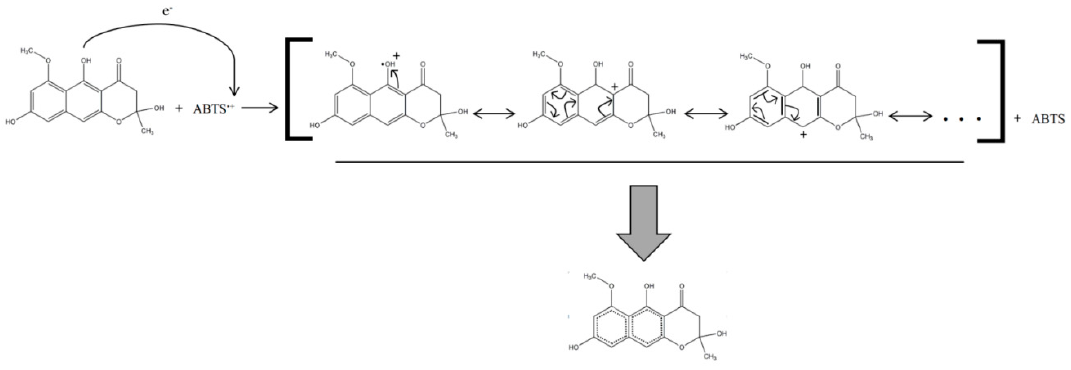
Figure 4. Radical scavenging mechanism of the fonsecin.